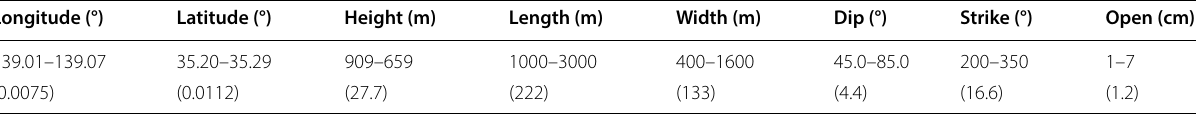
The step interval for each parameter is shown in parentheses